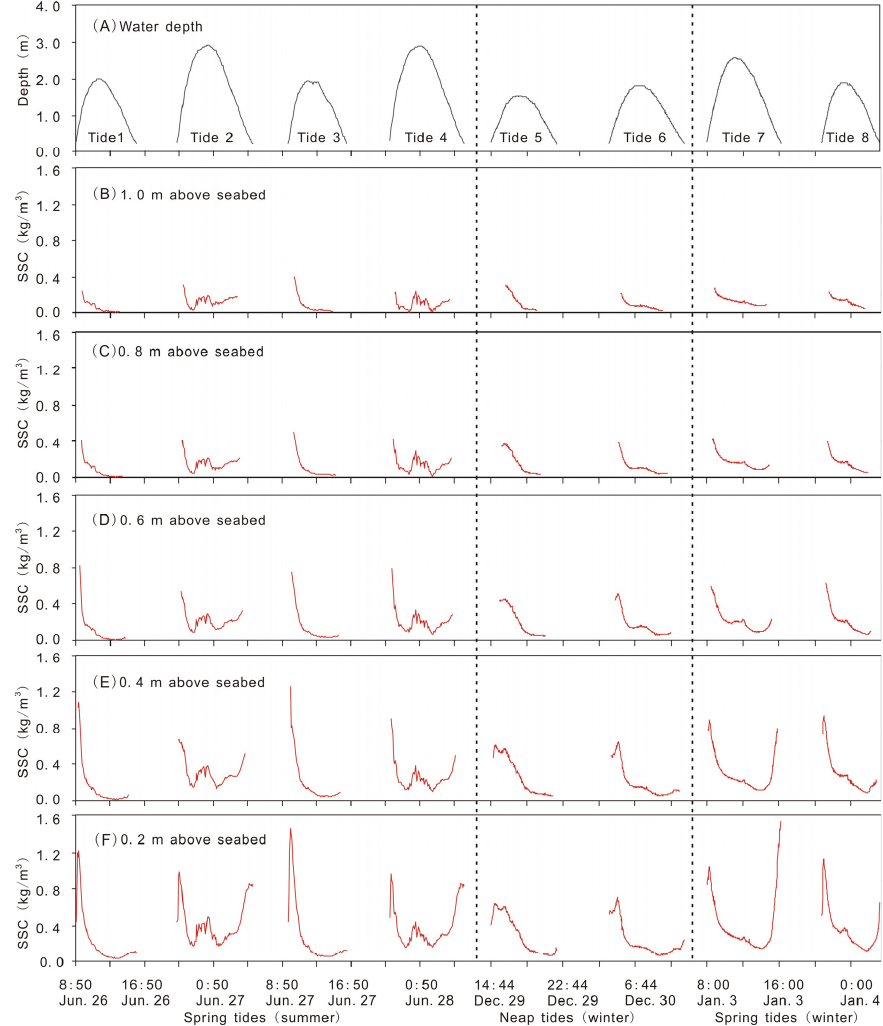
Figure 5. Time series of water depth ( A ), and SSC ( B – F ) at different heights above the seabed for the various seasons and tidal conditions.